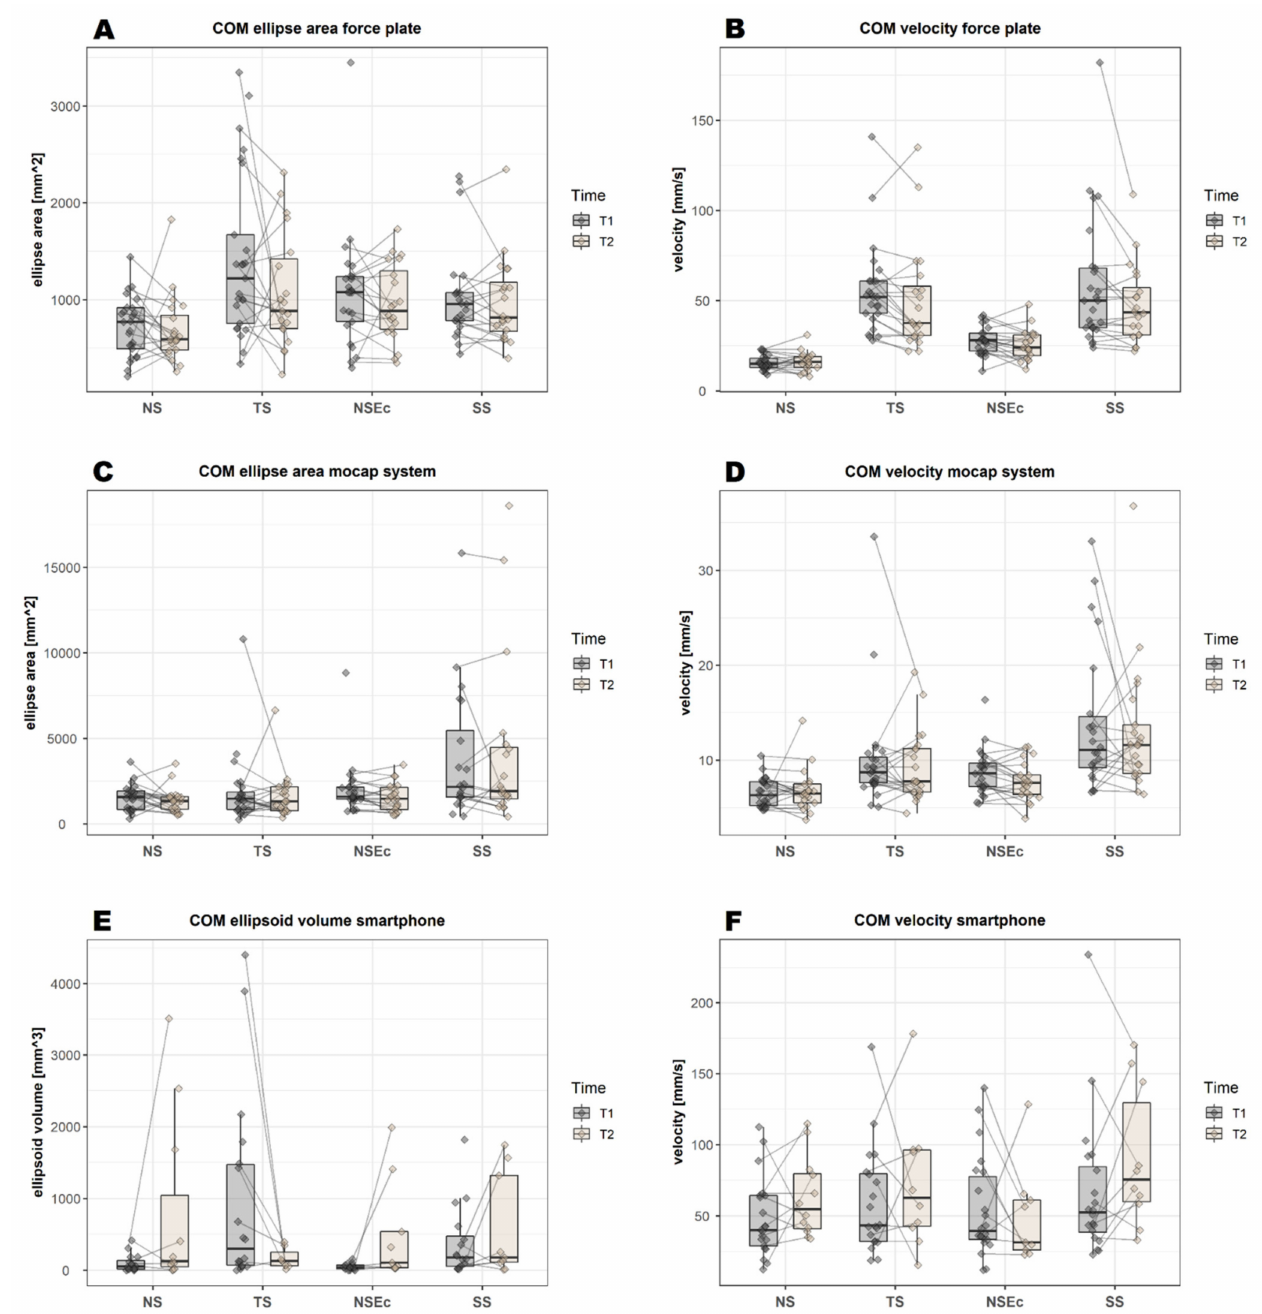
Figure 5. Graphical overview over the balance variables (center of mass ellipse area and velocity) in all three gait analysis systems at both measurement times (first measurement, T1, second measurement, T2). COM = center of mass, NS = narrow stance, TS = tandem stance, NSEc = narrow stance with eyes closed, SS = single leg